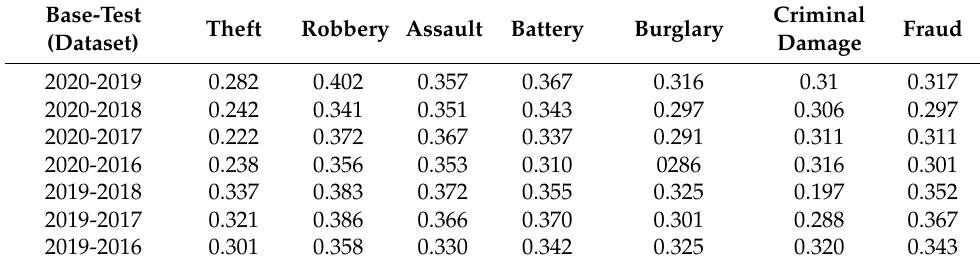
Table A1. The global S-index values of different crimes between base dataset and test dataset. The spatial unit of SPPT is the census tract of Chicago. “2020-2019” in the table means that the crime data of 2020 are the base dataset, and the crime data of 2019 are the test